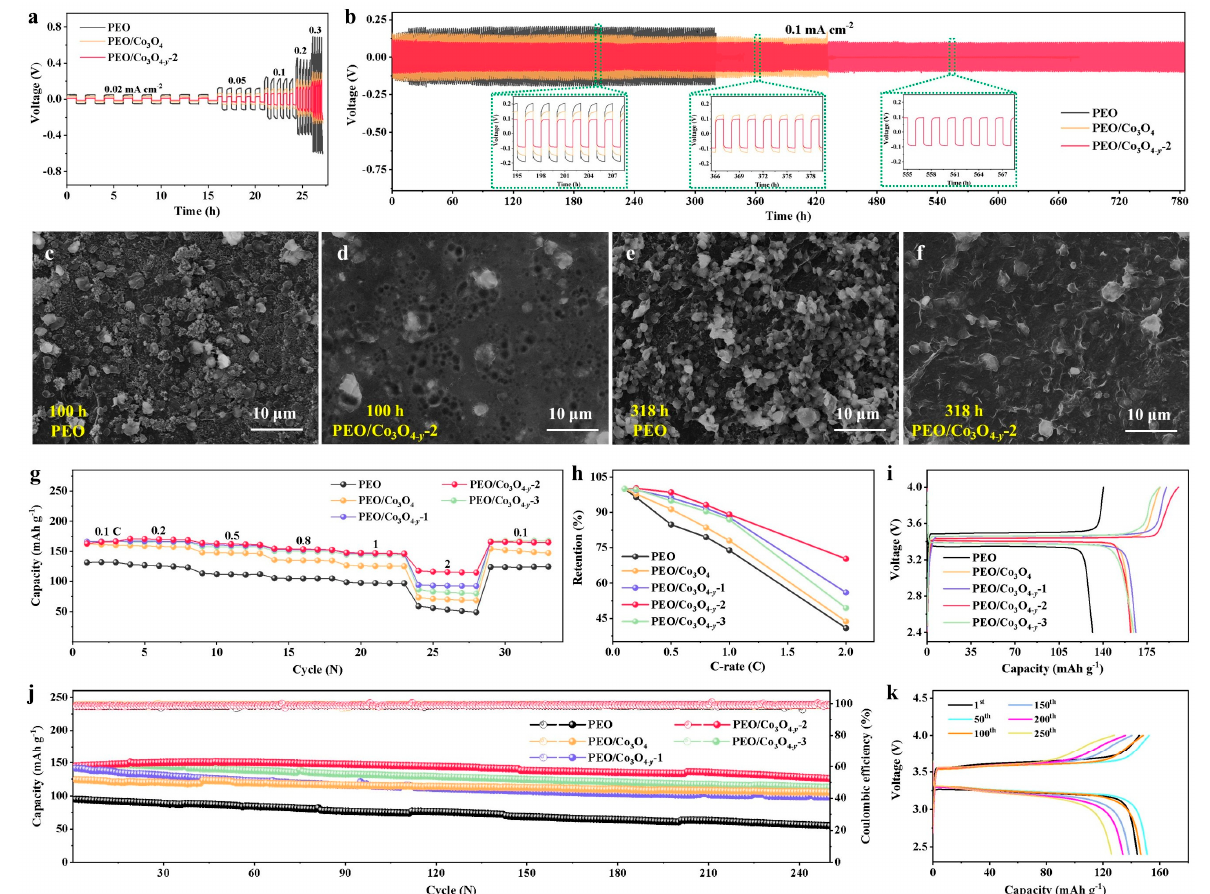
Figure 5. Ba tt ery test results of the electrolyte fi lms. ( a ) Rate performance and ( b ) voltage-time pro fi les of symmetric Li||SPE||Li cells using PEO, PEO/Co 3 O 4 and PEO/Co 3 O 4- y − 2 electrolyte fi lms. ( c – f ) SEM images of Li anode surface with ( c , e ) PEO and ( d , f ) PEO/Co 3 O 4- y − 2 as the electrolyte fi lms after cycling for 100 and 318 h. ( g , h ) Rate performance, ( i ) charge–discharge curves at 0.1 C, and ( j ) cycling performance at 1 C of LiFePO 4 ||SPE||Li cells using PEO, PEO/Co 3 O 4 and PEO/Co 3 O 4- y − x ( x = 1, 2 and 3) electrolyte fi lms. ( k ) Charge–discharge curves of the LiFePO 4 ||PEO/Co 3 O 4- y − 2||Li cell at di ff erent cycles.